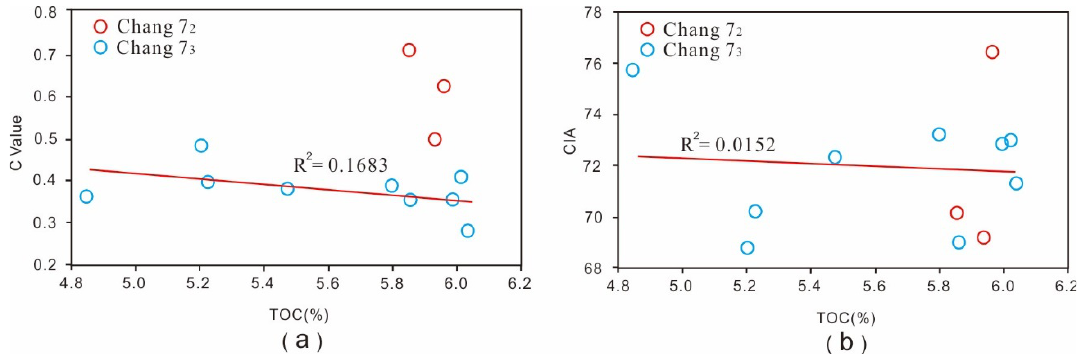
Figure 5. The cross-plot of paleoclimate indicators and TOC: ( a ) relationship between C and TOC; ( b ) relationship between CIA and TOC.